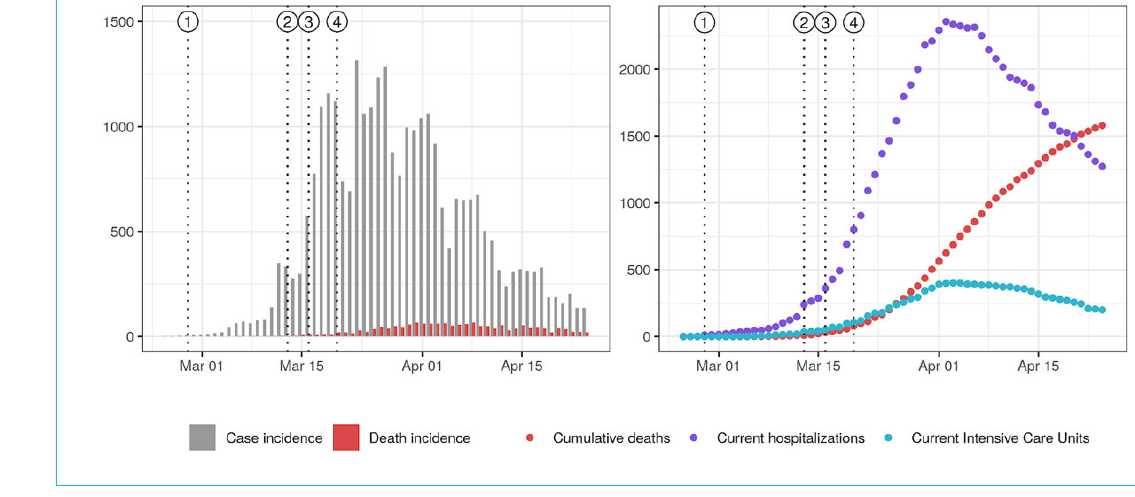
Figure 1: COVID-19 epidemic curve in Switzerland and timing of non-pharmaceutical interventions. Vertical dotted lines indicate the is- suing of NPIs: (1) ban on gatherings of more than 1000 people, (2) school closure, (3) closure of non-essential activities, and (4) ban on gath- erings of more than five people. Left: Daily case incidence at time of reporting along with death incidence. Right: Current hospitalisations, in- tensive care units (ICUs) and cumulative deaths. Plotted data was taken from Probst [17] and may therefore present inconsistencies with official reports from the Federal Office of Public Health due to reporting